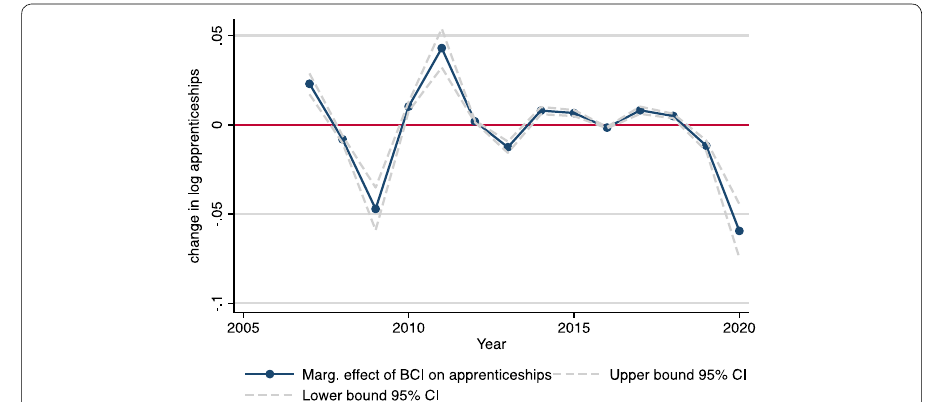
Fig. 7 Marginal effects of the BCI (ceteris paribus) on the number of new apprenticeships (2007–2018) and predicted effects for the years 2019 and 2020. Notes: Blue line indicates to what extent changes in the ifo BCI (average value of the second quarter of each year) affect the annual number of new apprenticeship contracts signed by the end of the same year. Out-of-sample forecasts for the years 2019 and 2020 that include current ifo BCI data for January 2019 – June 2020. Data sources: Vocational training statistics of the statistical offices of the federal and state governments, ifo Business Climate